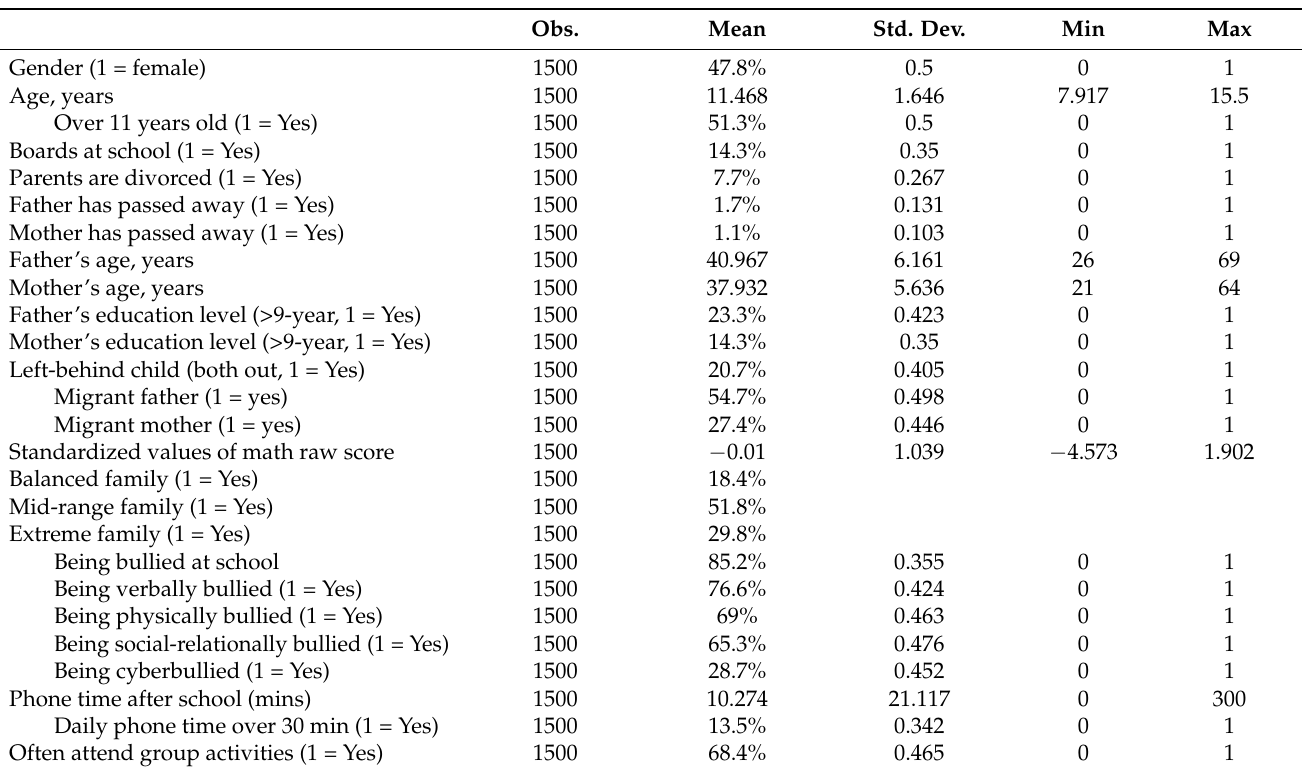
Table 1. Summary statistics of sample